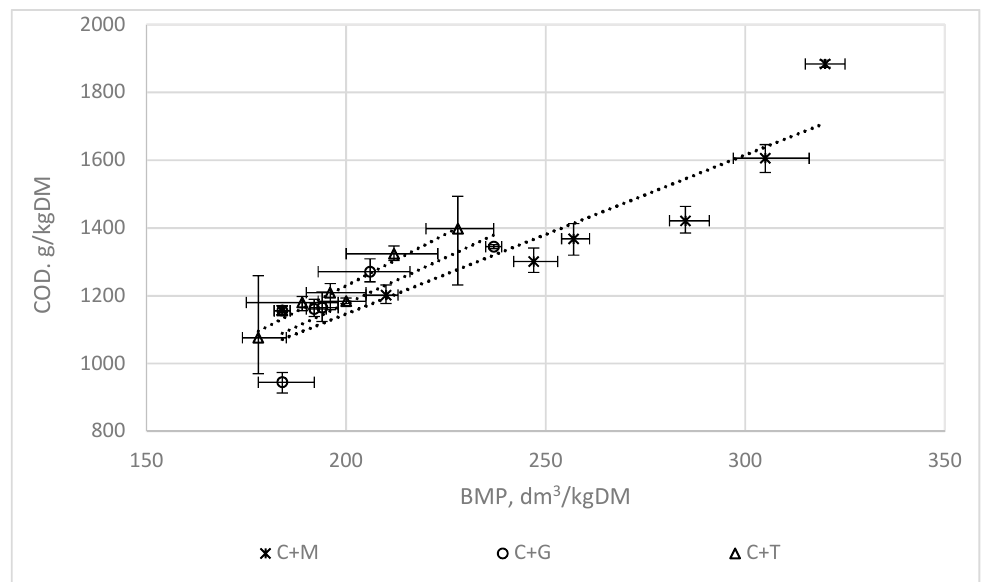
Figure 8 . The correlations between the COD index and the BMP . Figure 8. The correlations between the COD index and the